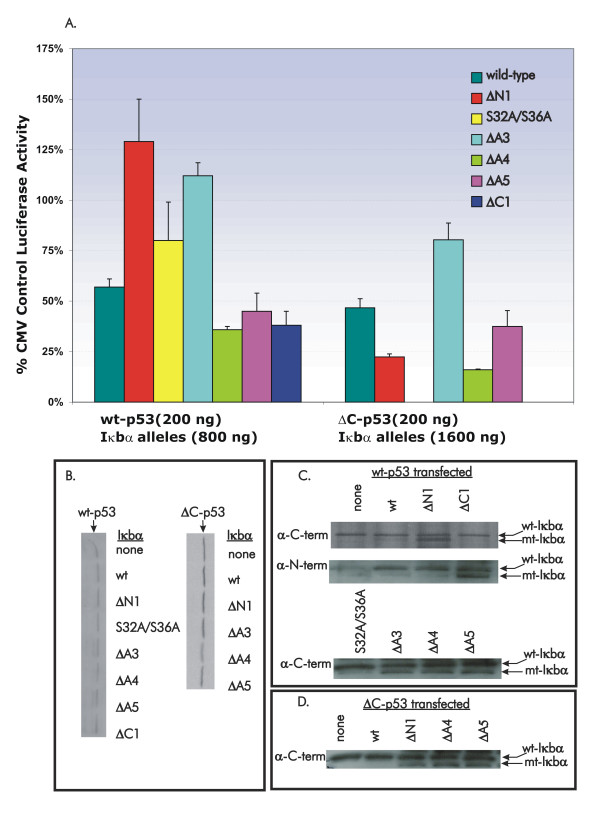
Transient transfection of IκBα alleles specifically blocks p53 transcription in EBV-positive Akata cells. A. 200 ng of a p53-dependent reporter plasmid encoding 13 copies of the p53 response element driving a firefly luciferase (pG(13)Py/Luc) were cotransfected into 2 × 105 cells with 1 ng of an SV40 promoter driven Renilla luciferase (pRLSV40) and 200 ng of a CMV-promoter driven wild-type p53 cDNA construct (wt-p53, denoted below the x-axis) or a C-terminally deleted transcriptionally active p53 (ΔC-p53, denoted below the x-axis). The effect of 800 ng of CMV-promoter driven IκBα alleles or a control construct that did not contain DNA encoding IκBα (to which all data were normalized) were used to determine the effect of IκBα on wild-type p53-mediated transcription of pG(13)Py/Luc while 1600 ng of CMV-promoter driven IκBα alleles (or control) were used in experiments where the ΔC-p53 allele was used. Immunoblotting controls for wt-p53, ΔC-p53 and IκBα alleles. B: Western blot analysis of wt-p53 and ΔC-p53 in the presence of transfected IκBα alleles. Extracts were derived from Akata cells as described for Figure 5A. None indicates transfection of empty CMV vector containing no IκBα allele. C: Western blot analysis for IκBα in the presence of transfected wt-p53. A subset of extracts were analyzed both with C-term and N-term directed IκBα antibodies. Endogenous IκBα is detected by these methods. D: Western blot analysis of IκBα in the presence of ΔC-p53. ΔA3 was analyzed on a separate gel due to space limitations and showed a band intensity similar to that of ΔA4 and ΔA5 (data not shown).